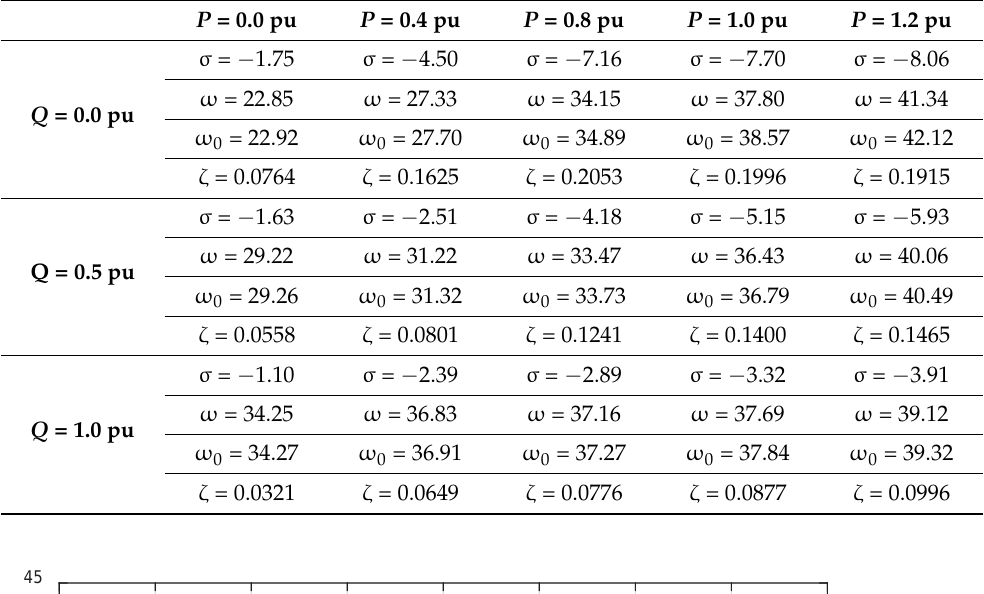
Table 10. Real and imaginary parts of the eigenvalues, the undamped natural frequencies, and the damping ratios of the local oscillations of the laboratory synchronous generator at different operating points.